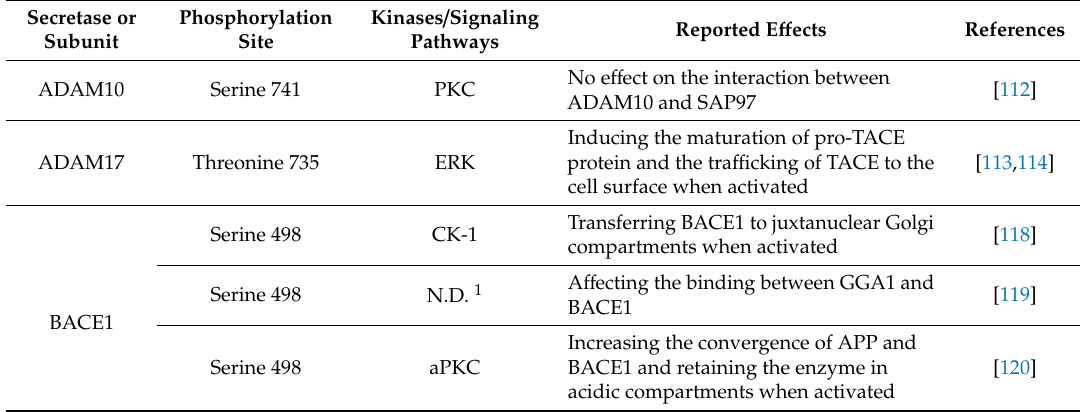
Table 2. Reported phosphorylation sites of α - and β -secretases and subunits of γ -secretase and their e ff